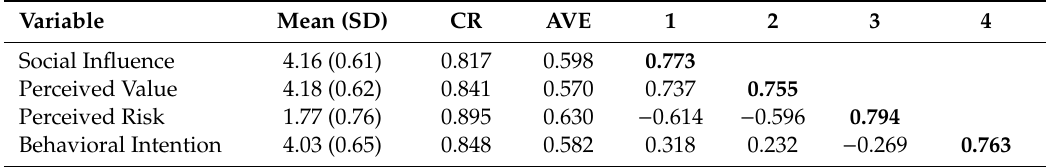
Table 2. Measurement